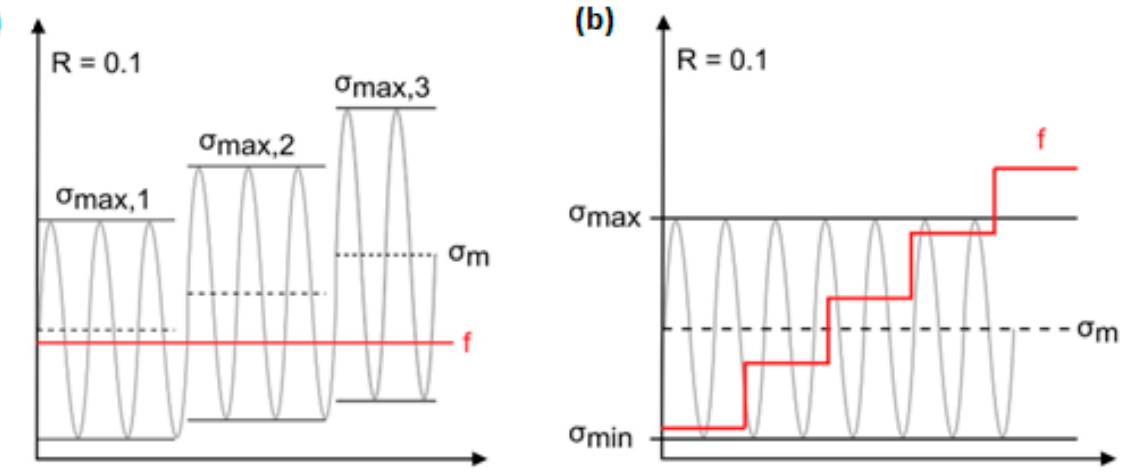
Figure 4. The schematic demonstration of ( a ) applying multiple-amplitude cyclic loads and ( b ) multiple-amplitude frequencies, adapted with permission from Ref. [11]. Copyright © 2020 Elsevier